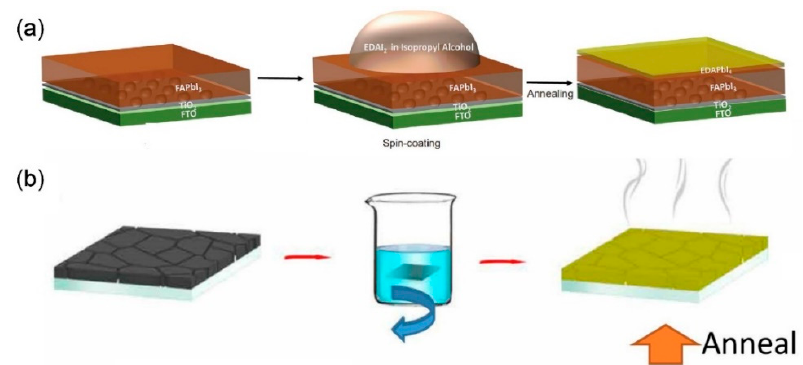
Figure 2. Schematic experimental process of the in-situ method conducted by ( a ) spinning and ( b ) dipping. Reprinted with permission from ref 29 Copyright 2019 Springer Nature and Ref. [25] Copyright 2019 American Association for the Advancement of Science (AAAS).